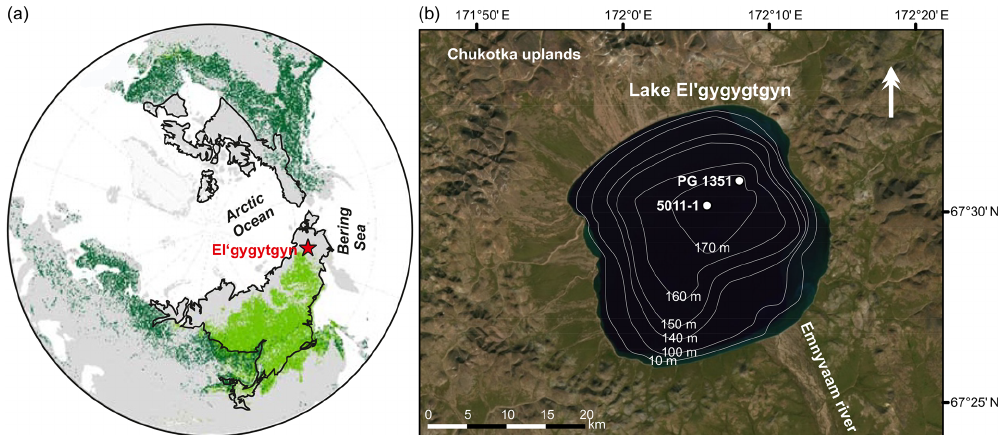
Figure 1. (a) Distribution of high-northern summer- and evergreen boreal forest (light and dark green, respectively) and location of Lake El’gygytgyn (red star). Black lines mark approximate modern continuous permafrost extent (after Williams and Ferrigno, 2012), land cover classification based on data © ESA Climate Change Initiative Land cover project, and land cover CCI, provided via the Centre for Environ- mental Data Archival (CEDA). (b) Lake El’gygytgyn and location of analysed sediment cores (map: © Landsat-7 image, courtesy of the U.S. Geological